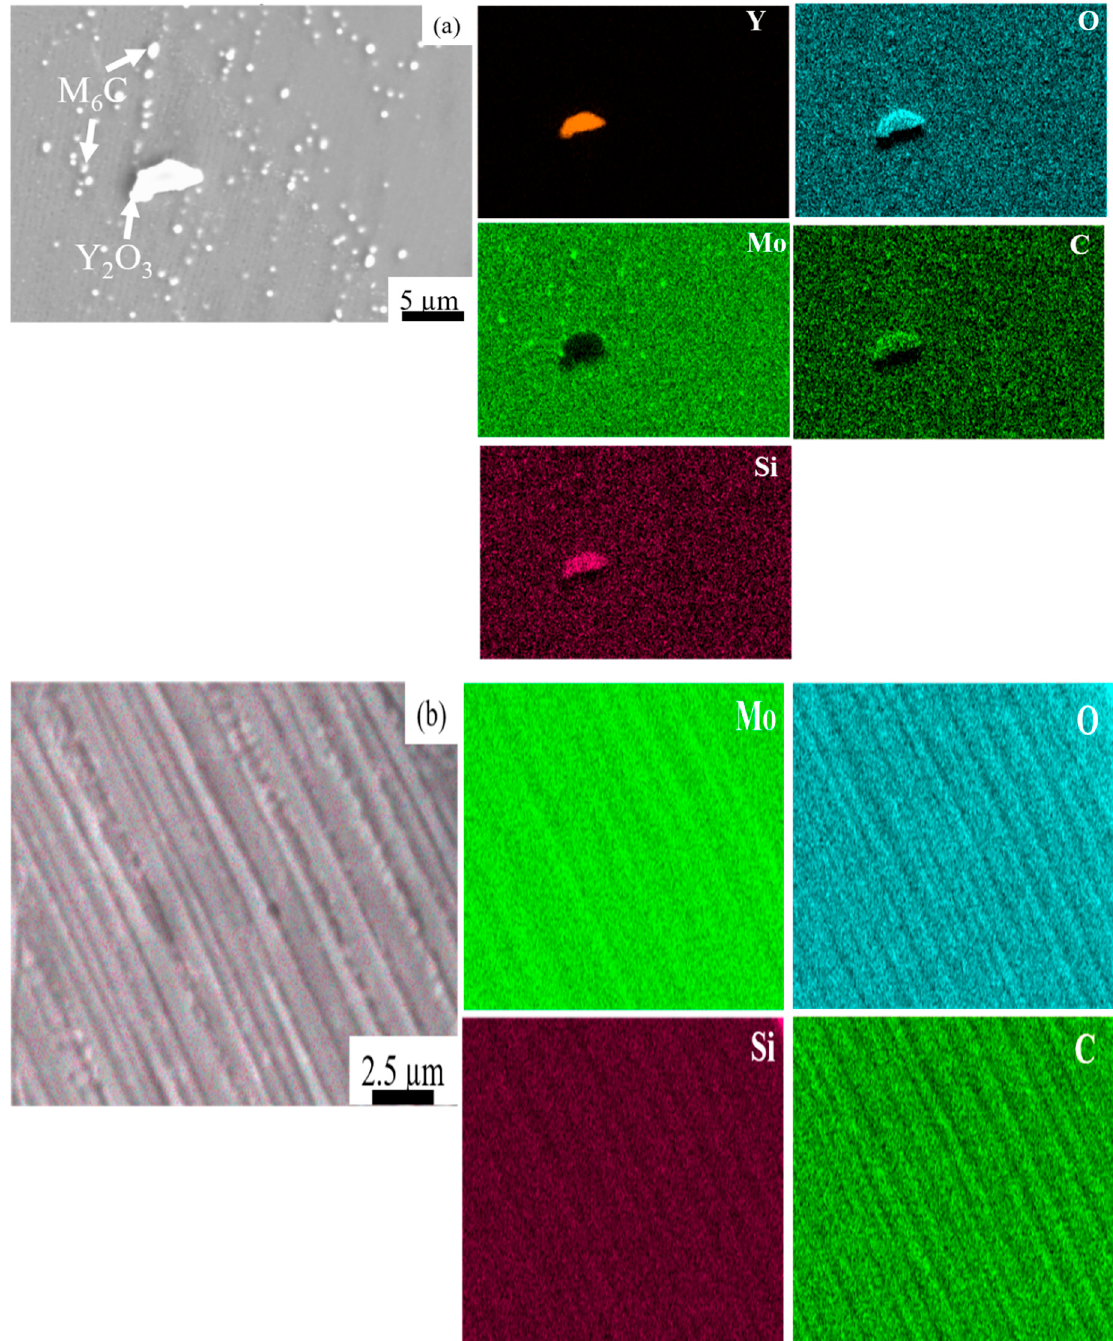
Figure 9. EDS mapping of ( a ) an HX-a ST specimen inside the grain and ( b ) an HX-a as-built sample at the interdendritic regions.